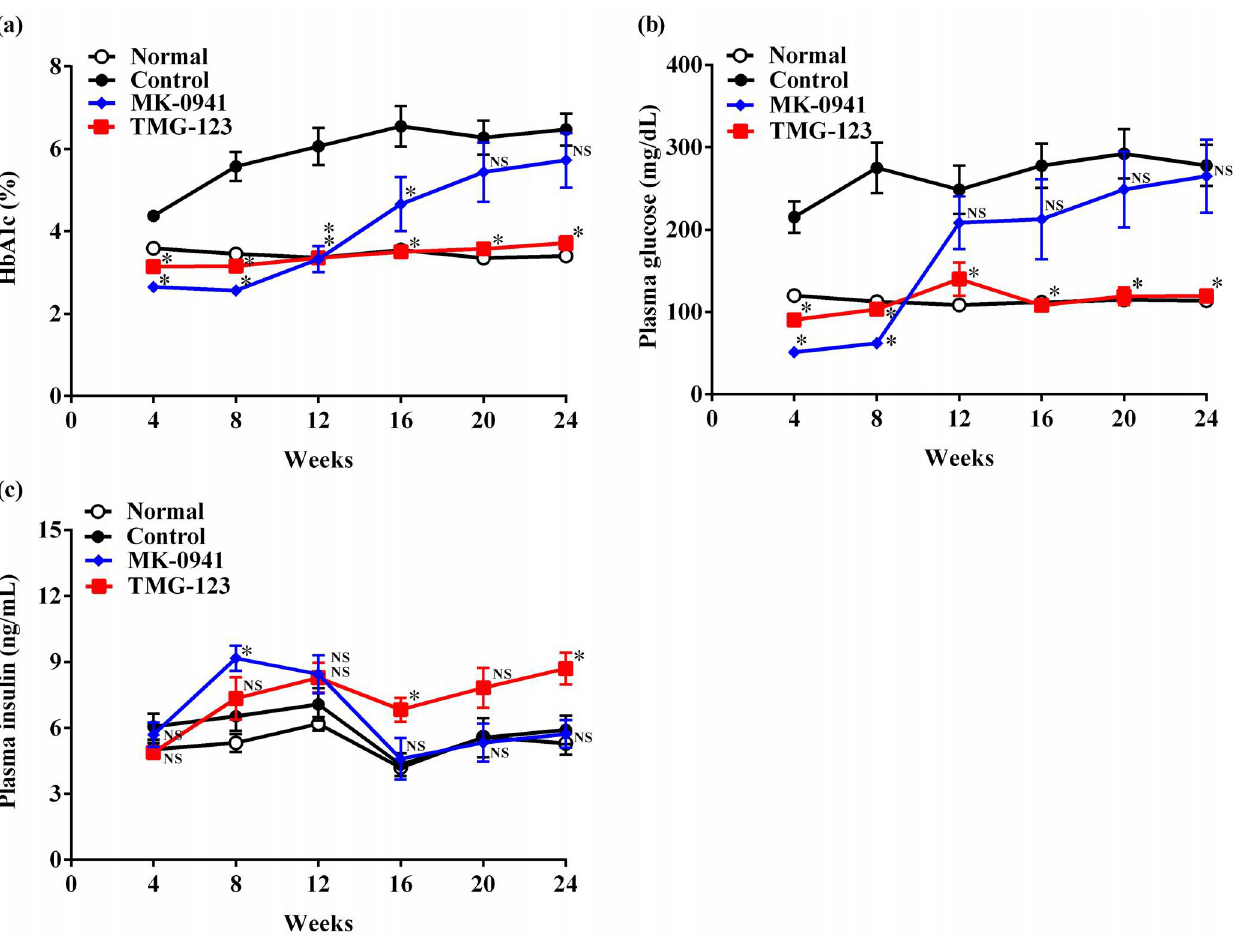
Fig 2. HbA1c, plasma glucose and plasma insulin levels in the chronic treatment study. Time course of (a) HbA1c level, (b) plasma glucose level, and (c) plasma insulin level during the chronic treatment study. Normal; Wistar rats, Control; Goto-Kakizaki rats fed normal diet, n = 7–8. � p < 0.05, NS = not